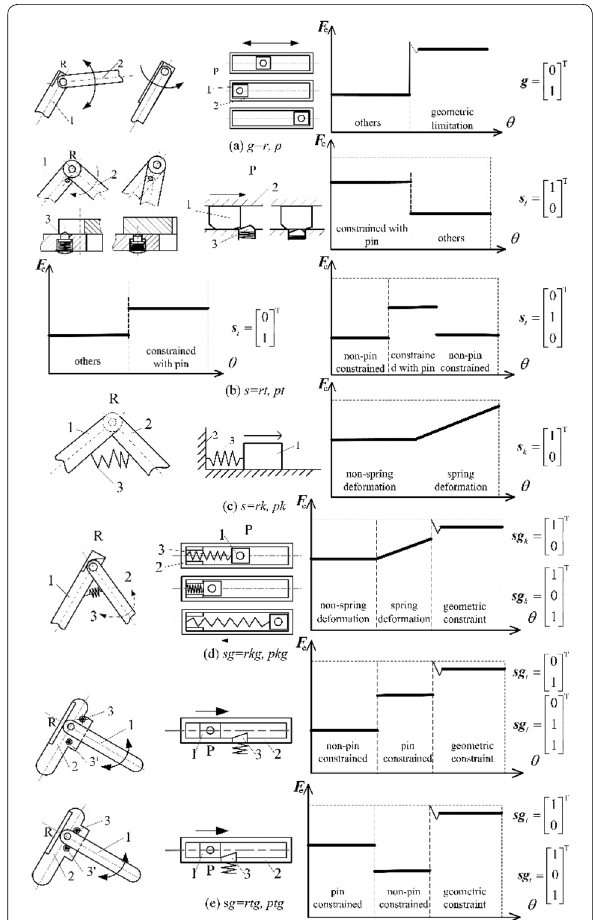
Figure 3 Constrained structures and force characteristic sketches of metamorphic joints (This figure is reprinted with permission from